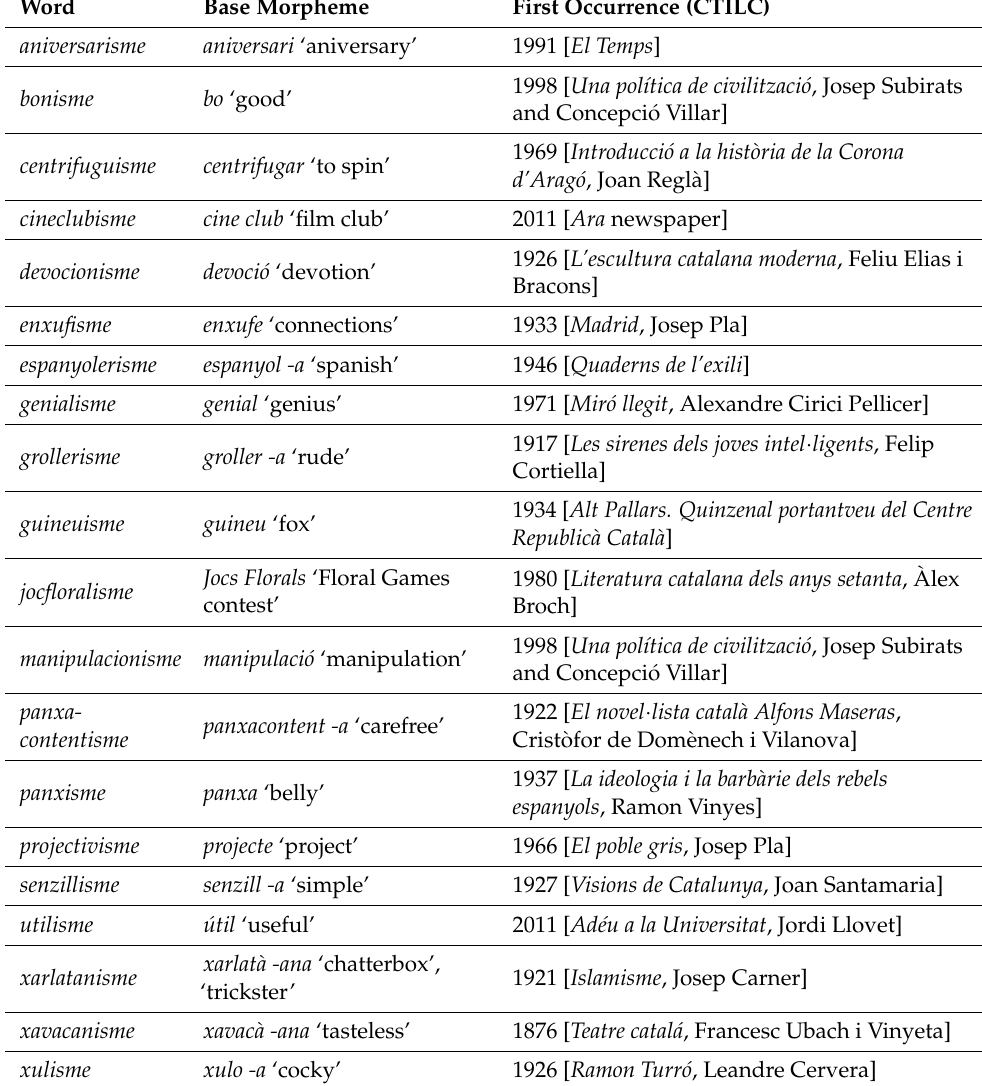
Table 3. Some lexical innovations with the suffix - isme ‘-ism’ registered in the CTILC.